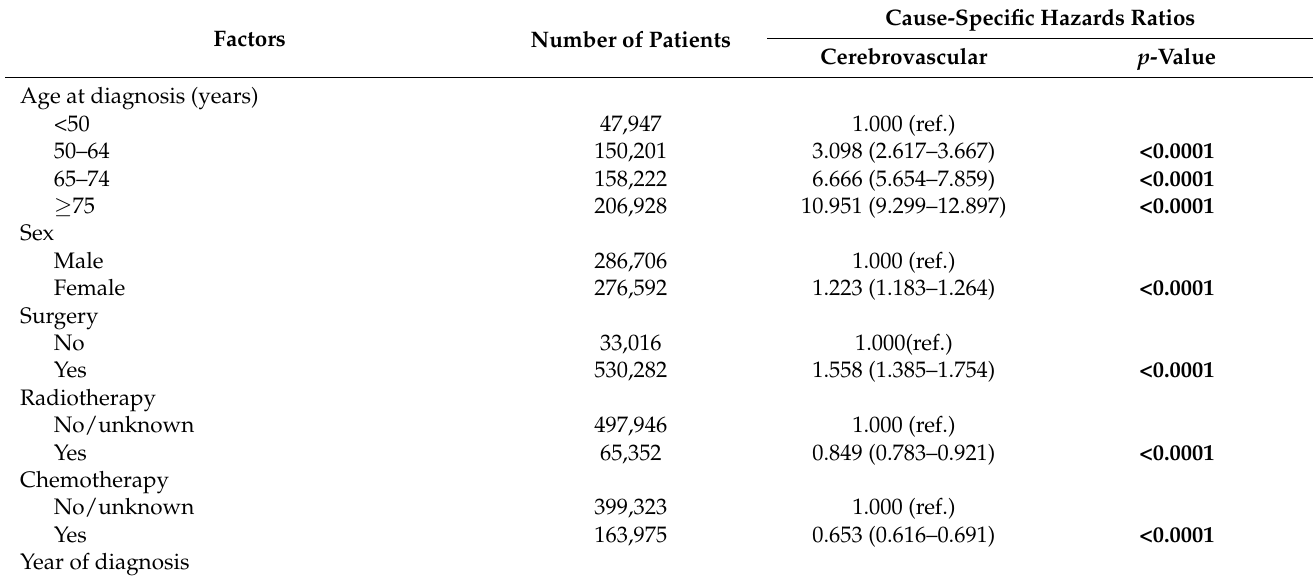
Table 3. Cause-specific hazard and 95% confidence intervals for cerebrovascular-related mortality among colorectal cancer